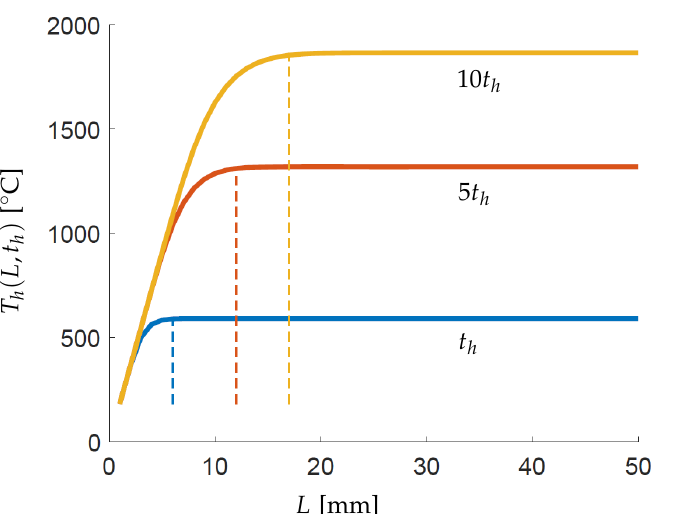
Figure 10. Variation of peak temperatures attained at the end of the heating step with respect to domain size L as described by Equation (20). Three graphs are shown for varying heating time t h and vertical lines are shown for respective Fo = 0.3. First 10,000 terms of the infinite series given by Equation (20) are considered for